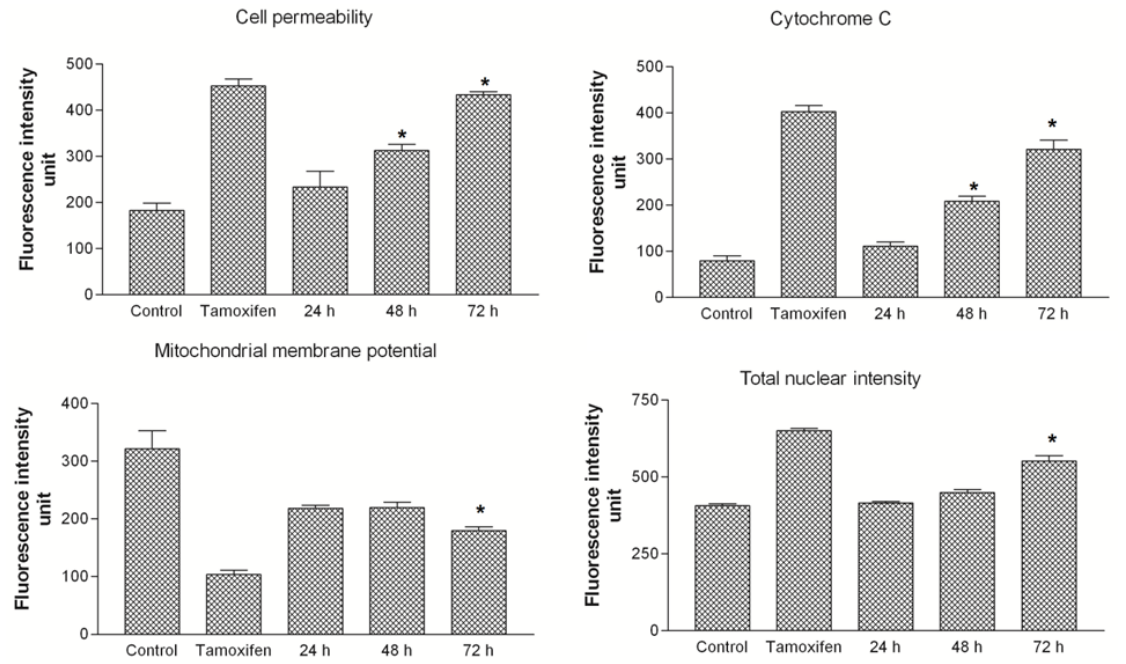
Figure 9. The analysis of TPHE mediated apoptosis markers. Changes in cell membrane permeability, cytochrome c localization, MMP and total nuclear intensity were all quantified simultaneously in MCF7 cells. Treatment with TPHE caused a significant elevation in cell membrane permeability, nuclear intensity and cytochrome c release associated with loss of MMP. The data are shown as the mean ± SD ( n = 3). * represents significant difference ( p < 0.05) compared with the control.